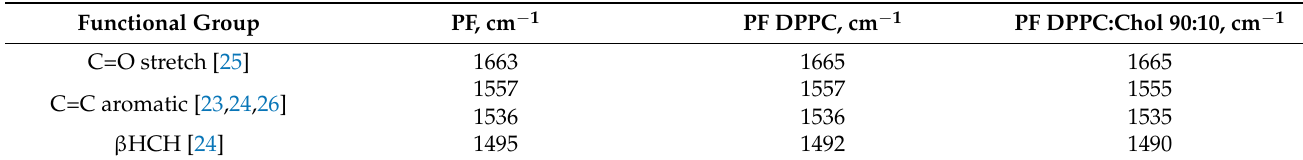
Figure 1. ( a ). Calibration curve for pirfenidone in sodium-phosphate-buffered solution based on UV-Vis spectra. ( b ). ATR-FTIR spectra of pirfenidone (4 mg/mL) in 0.02 M sodium-phosphate-buffered solution pH 7,4. In insertion: pirfenidone structure. c. UV-spectrum of pirfenidone. Table 1. Main peak positions in ATR-FTIR spectra of pirfenidone solution and DPPC and DPPC:Chol 90:10 liposomes.